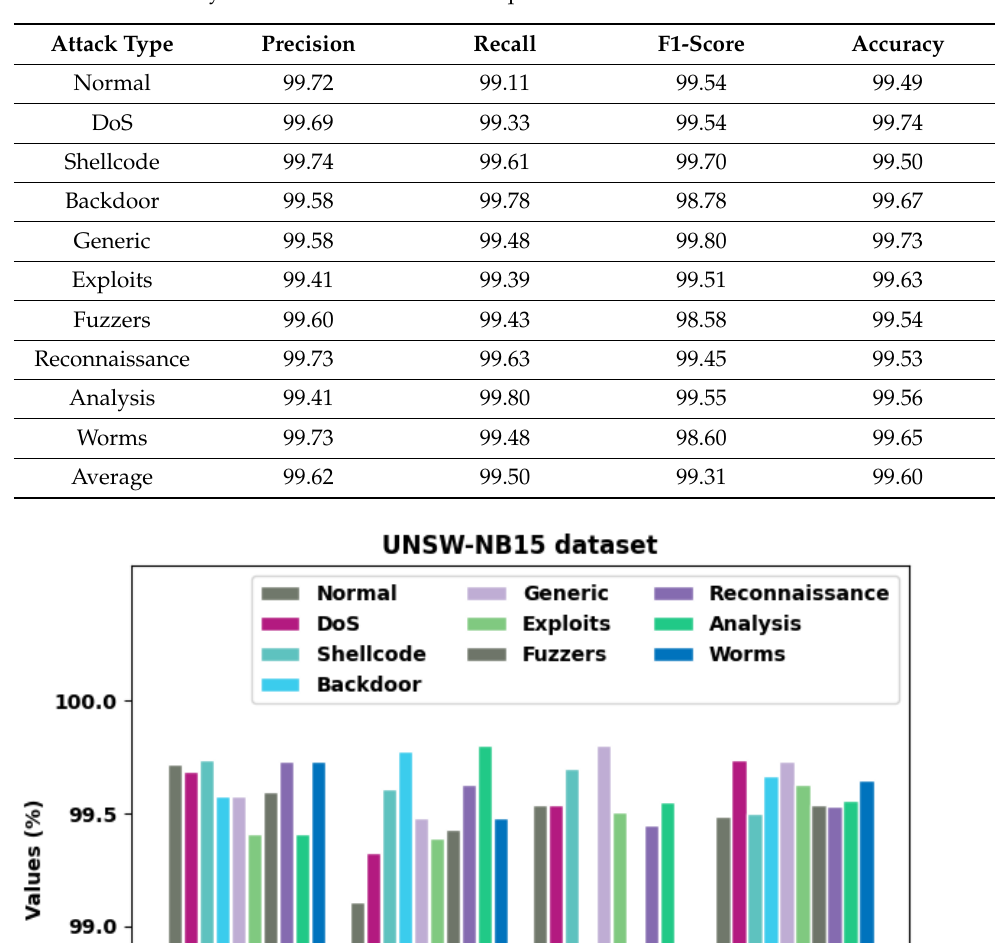
Table 3. Result analysis of OMLIDS-PBIoT technique on UNSW-NB15 dataset.